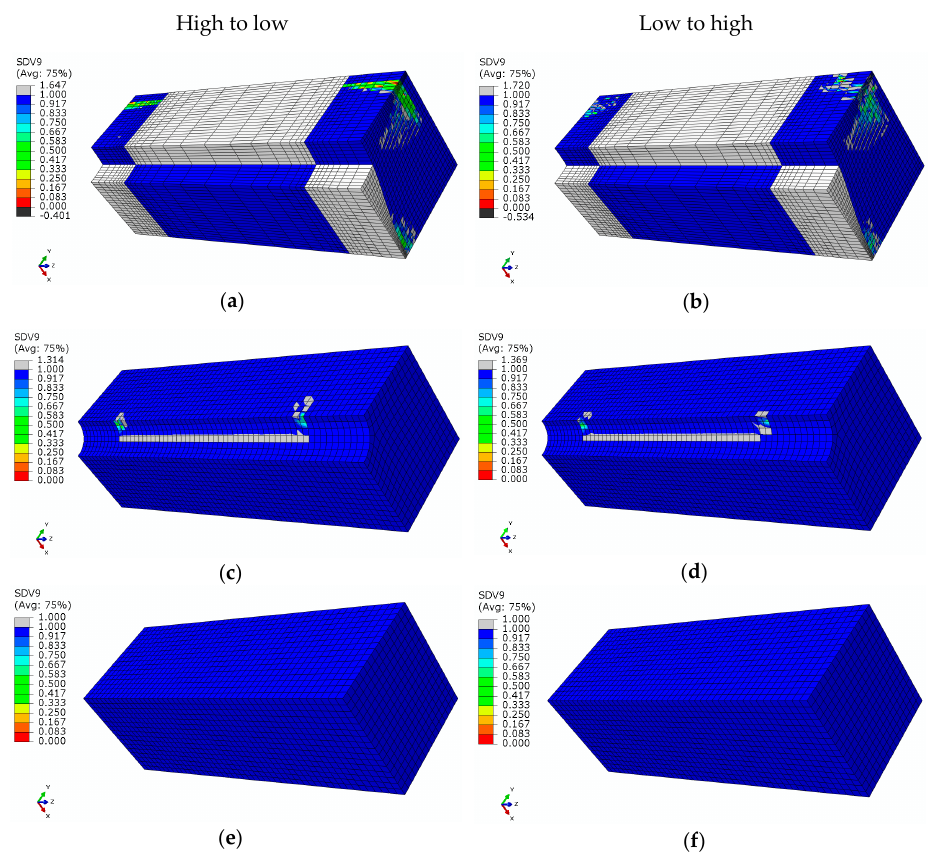
Figure 18 . Strength degradation in transverse direction for all three micro models: ( a , b ) perforated with CFP, ( c , d ) perforated without CFP, ( e , f ) unperforated. Left column load sequence high to low, right column load sequence low to high.